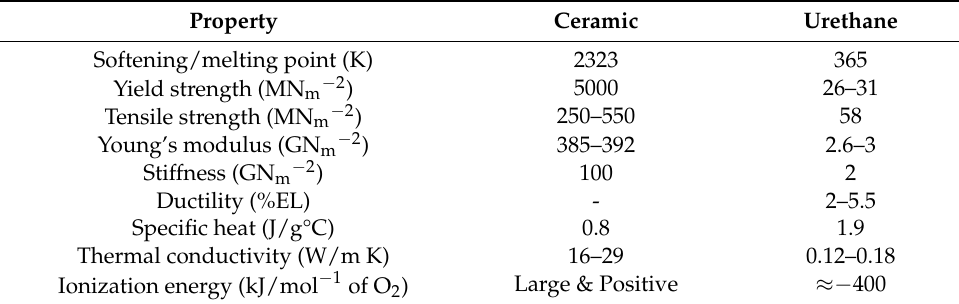
Table 1. Material